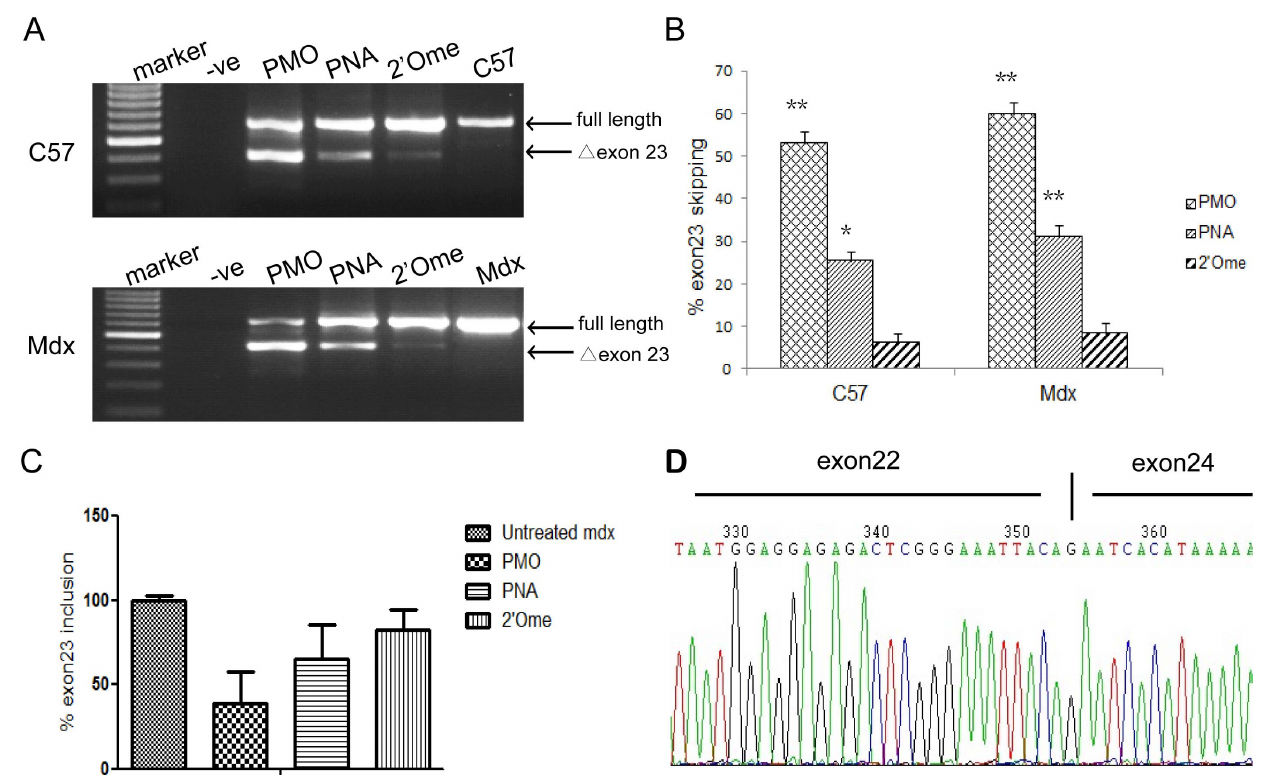
Figure 1. Effective exon skipping in C57BL6 and mdx mice by local intramuscular injection of different AOs. (A) RT-PCR for detecting exon skipping at the RNA level with treated TA muscles 48 hr after intramuscular injection of 2 m g PMO, 5 m g PNA and 5 m g 2 9 Ome PS in C57BL6 and mdx mice. The numbered D exon23 is for exon 23 skipping. –ve stands for RT-PCR blank control and the same below unless otherwise specified. (B) Quantitative analysis of exon skipping induced by different AOs in C57BL6 and mdx mice (**P , 0.001; *P , 0.05, n=3). (C) Quantitative PCR validation for detecting exon skipping at the RNA level with treated TA muscles 48 hr after intramuscular injection in mdx mice. (D) Sequence analysis of the exon 23 skipped band in the RT-PCR